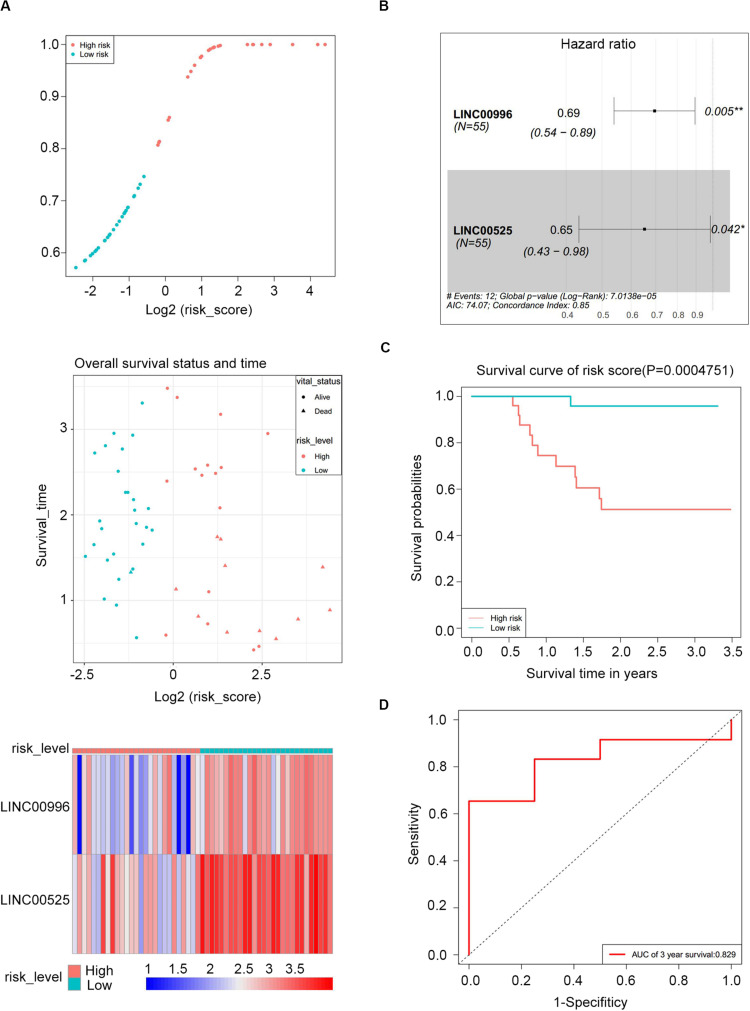
Risk score performance in the GSE57317 (training) datasets. (A) Risk score of the two lncRNAs in 55 MM patients (top); overall survival status and duration (middle); heatmap of the two lncRNA expression in MM patients (bottom). (B) Forest plot showing the hazard ratios with 95% confidence interval of the multivariate Cox regression results. (C) Overall survival of the high- and low-risk score groups. (D) Three-year survival receiving operating characteristic curve (ROC) according to the two-lncRNA signature risk score (red).